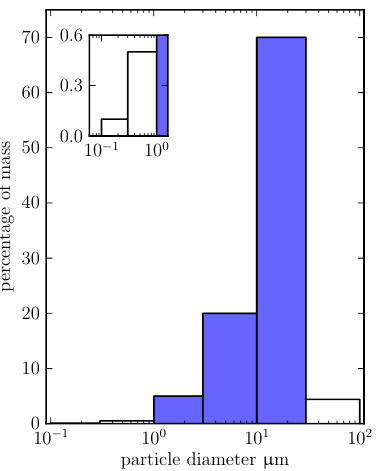
Figure 1. The mass distribution of particle size as used in the NAME simulations. The distribution is presented as a histogram showing the percentage of mass in each of a number of bands. The mass distribution of the log of the particle size is uniform in each band. The size range detectable in the satellite retrievals (1 µ m to 30 µ m) is shown in blue. The inset shows the distribution of the finest ash in more